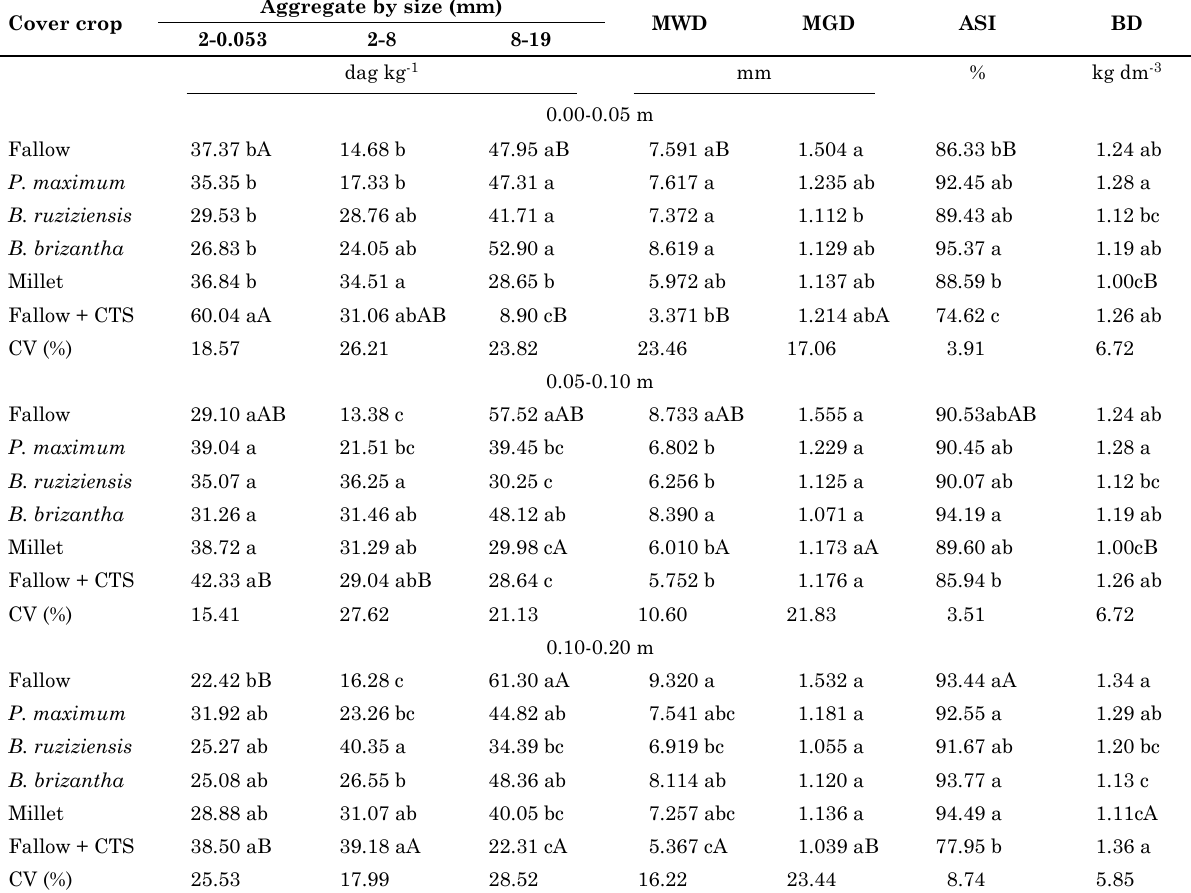
table 2. effects of cover crops in rotations with rice under a no-till system on weight of soil aggregates by size class, the soil aggregation indices of mean weight diameter (mWd), mean geometric diameter (mgd), and the aggregate stability index (ASi), and soil bulk density (bd) at different soil depths cover